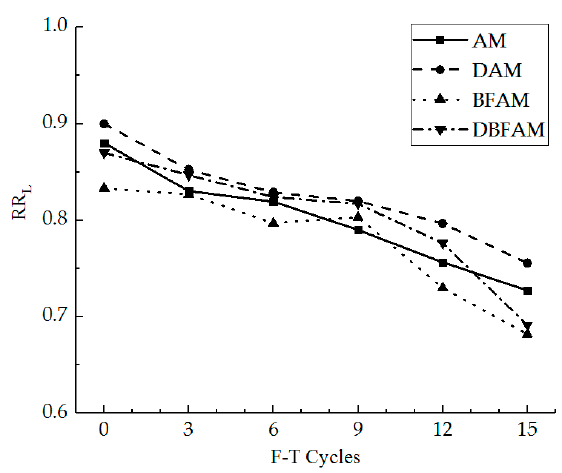
Figure 14. Linear zone stress ratio under F–T cycles.